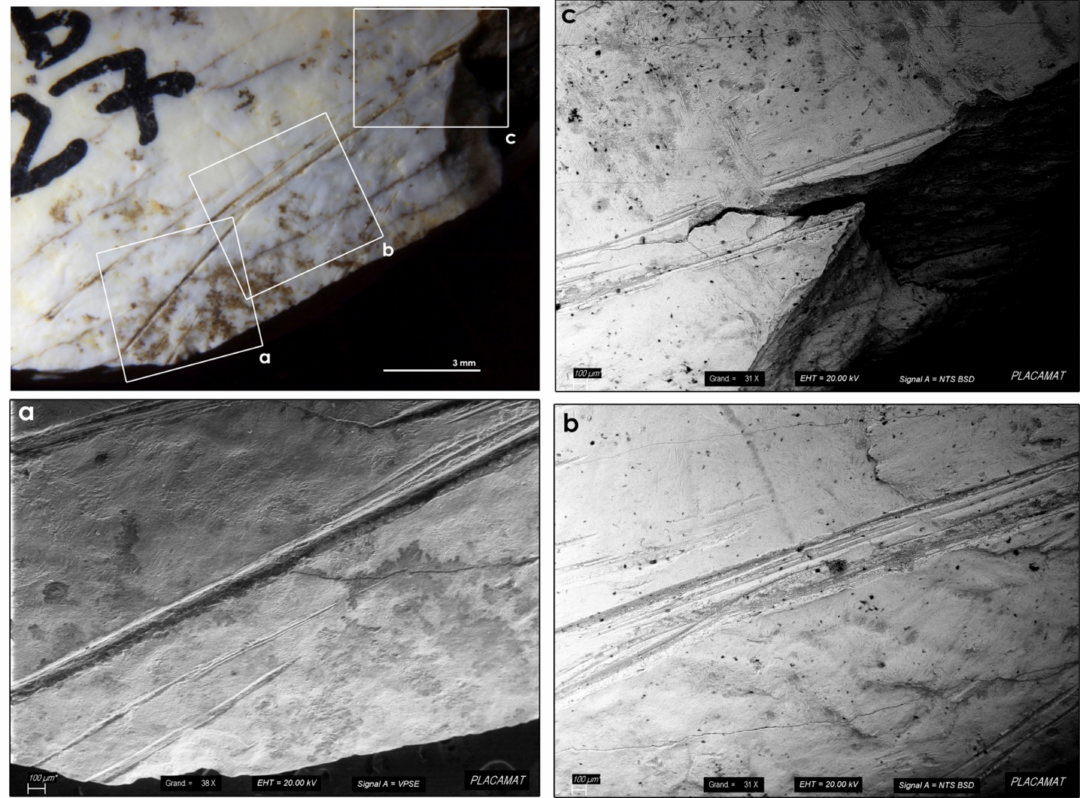
Figure 5. Detail of the cut marks observed on the large raptor femur ( a – c